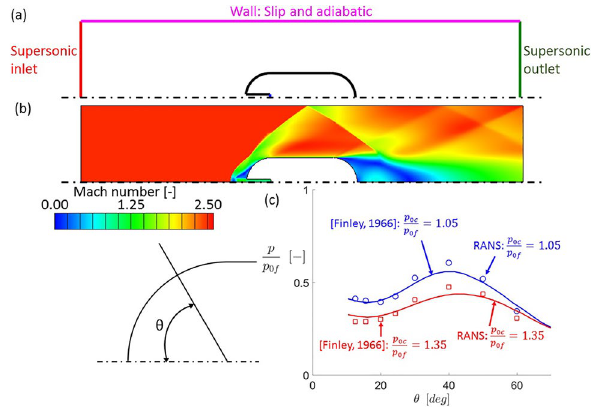
Figure 4. Validation case ( a ) computational domain and (b) Mach number contour for p 0 c / p 0 f = 1.05 and ( c ) leading edge experimental and numerical static pressure distributions.